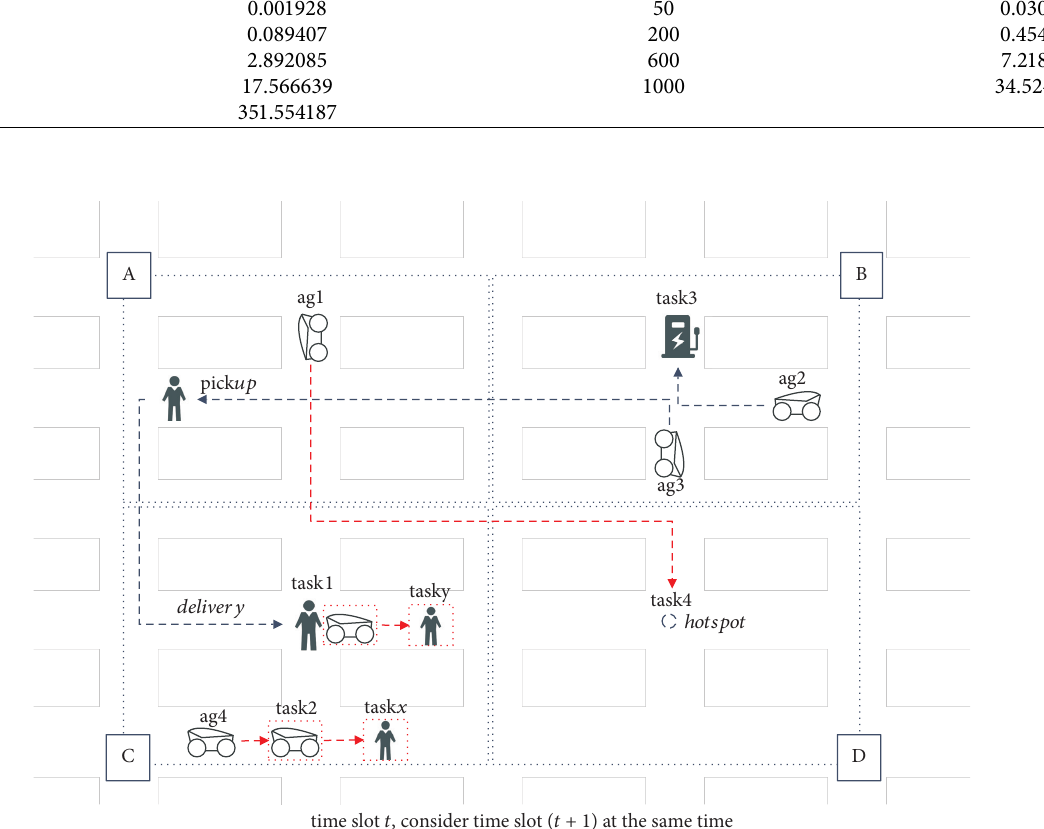
Figure 4: Multiaction allocation instructions at time slot t considering time slot ( t + 1 ) .